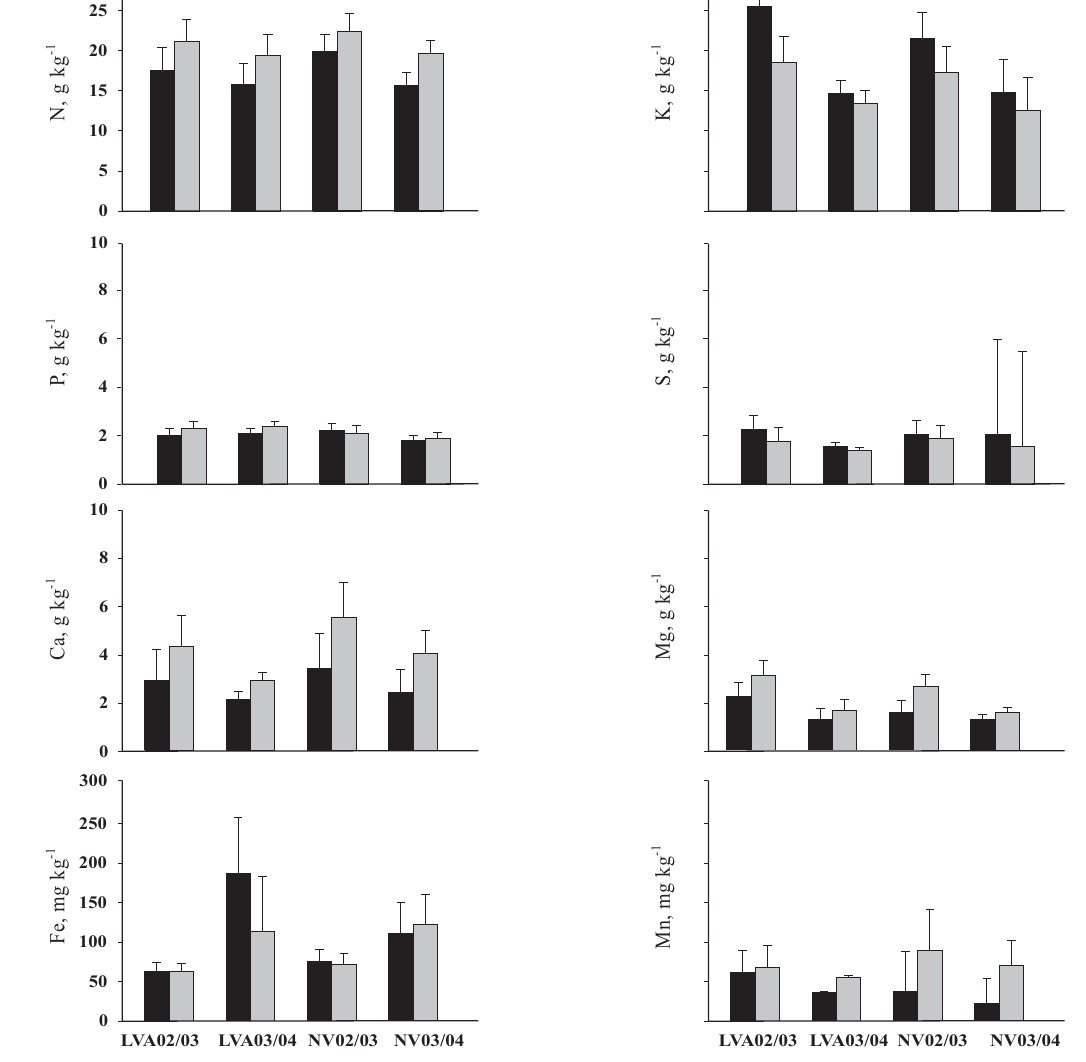
Figura 3. Teor foliar de macronutrientes e micronutrientes nas safras 2002/2003 e 2003/2004 para dois cultivares de cana-de-açúcar plantados nos solos LVA e NV. Diferença Mínima Significativa (DMS) a 5